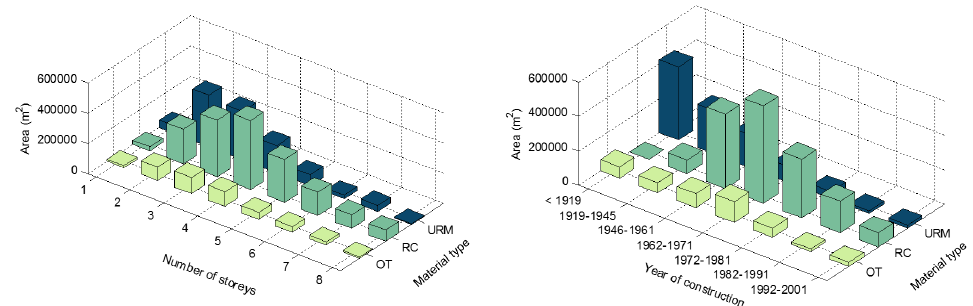
Figure 1. Distribution of residential building footprint areas in the municipality of Pavia, according to structural material type (URM, unreinforced masonry; RC, reinforced concrete; OT, others), number of storeys and year of